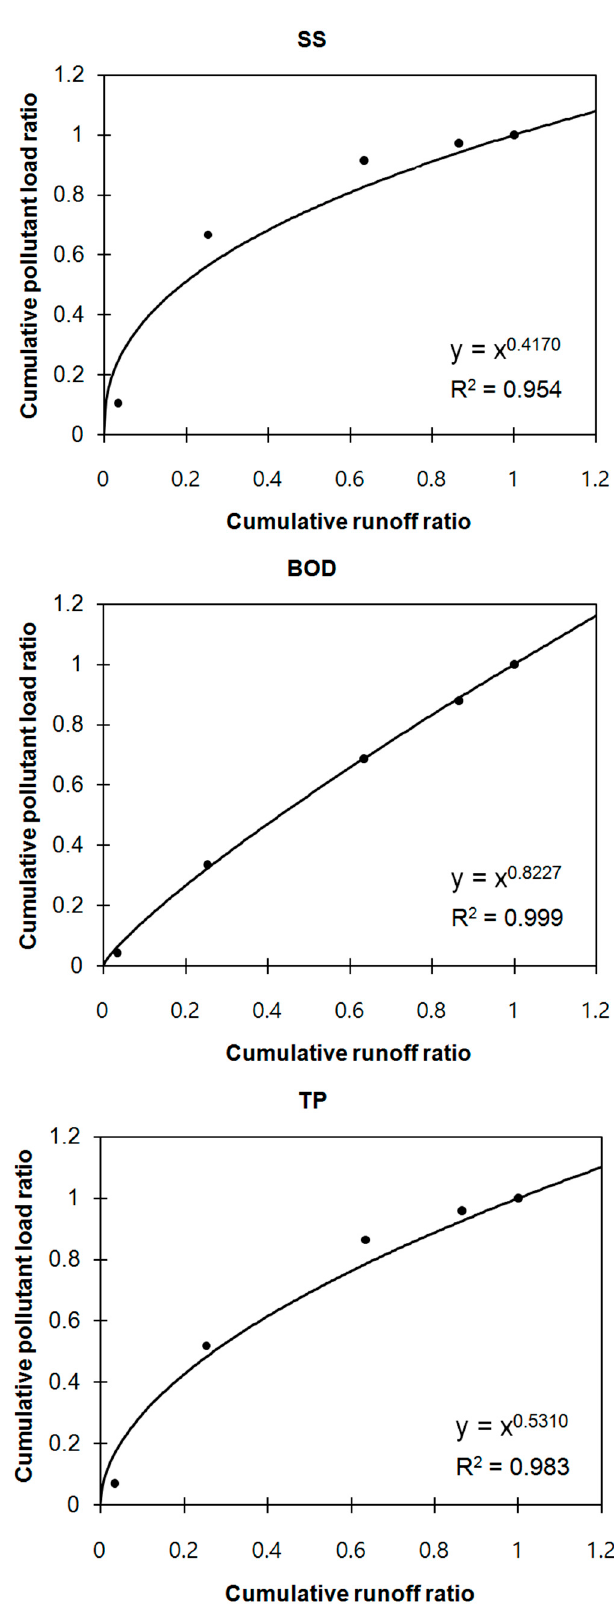
Figure 9. M(V) curve fitting using the power function for Jungjohangcheon (1–2 July 2016). Figure 9. M ( V ) curve fitting using the power function for Jungjohangcheon (1–2 July